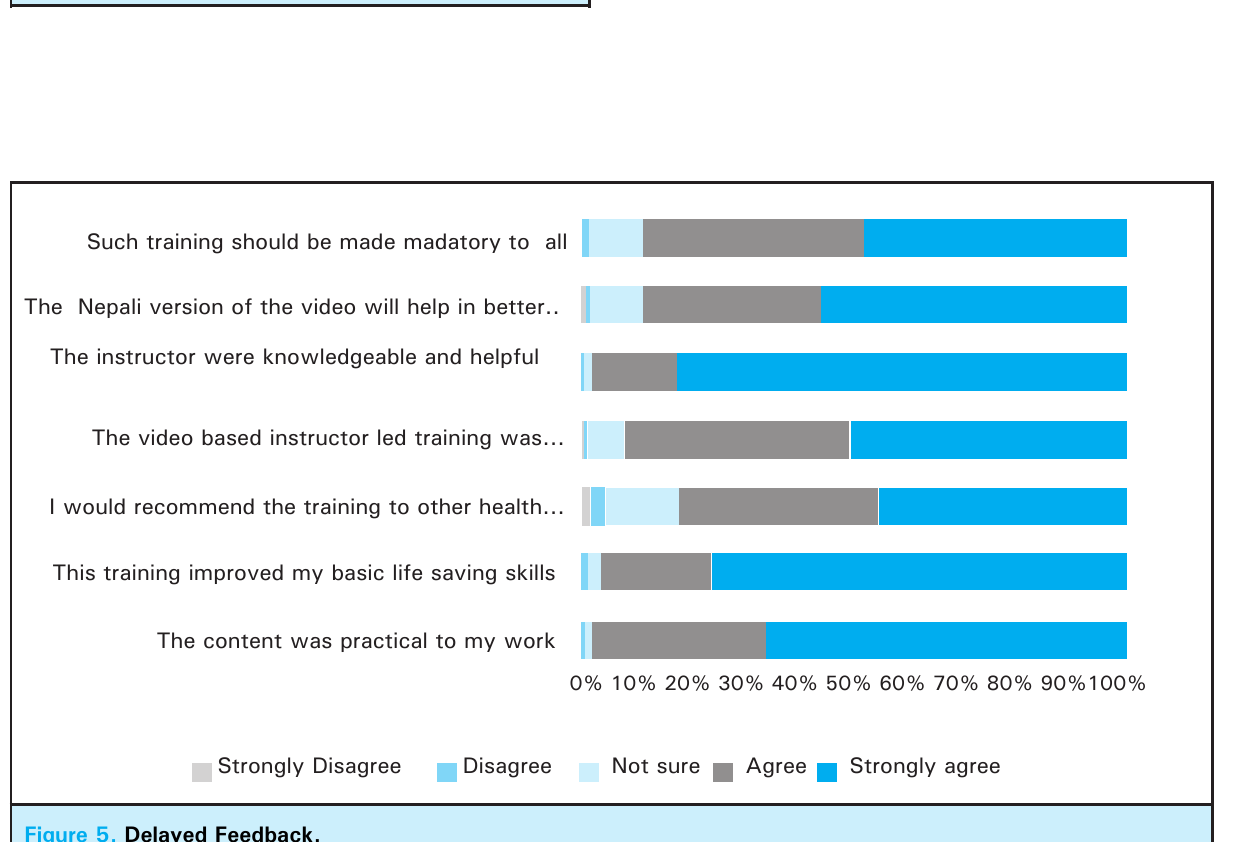
Figure 2. Adult BLS feedback.